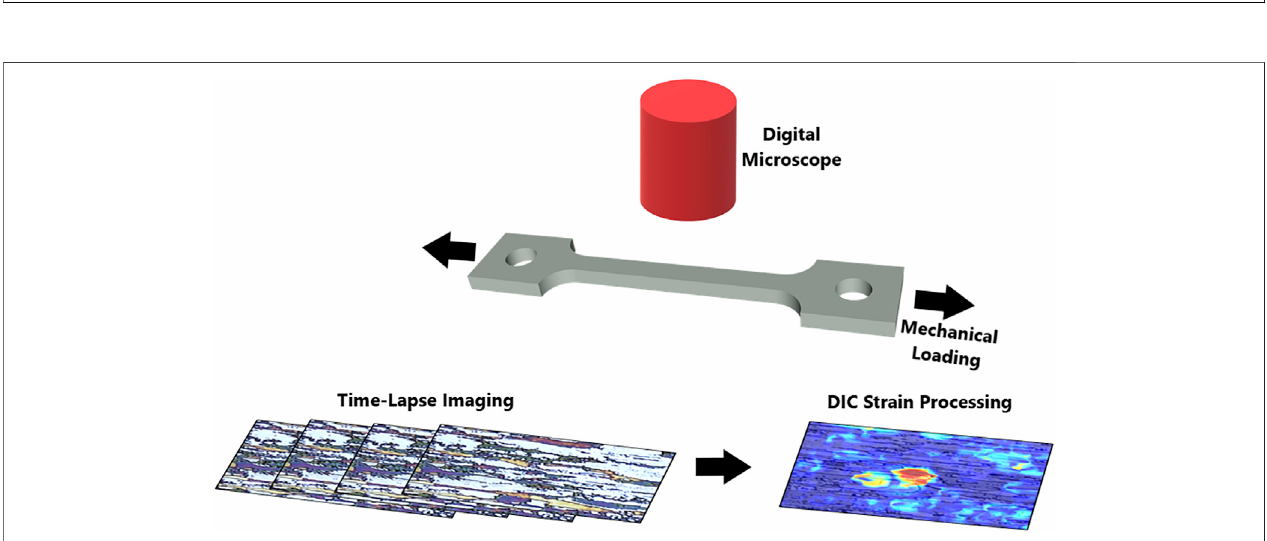
FIGURE 5 | Schematic illustrating the experimental setup for in-situ imaging of the microstructure in time-lapse during mechanical loading of the tensile specimen. Then, theimagesaretransferredtodigitalimage correlation softwareforthecomputationoflocalstraindevelopment.Usingadigitalmicroscopewithanextendedfocus range enables imaging with constant all-in-focus over the entire elongation